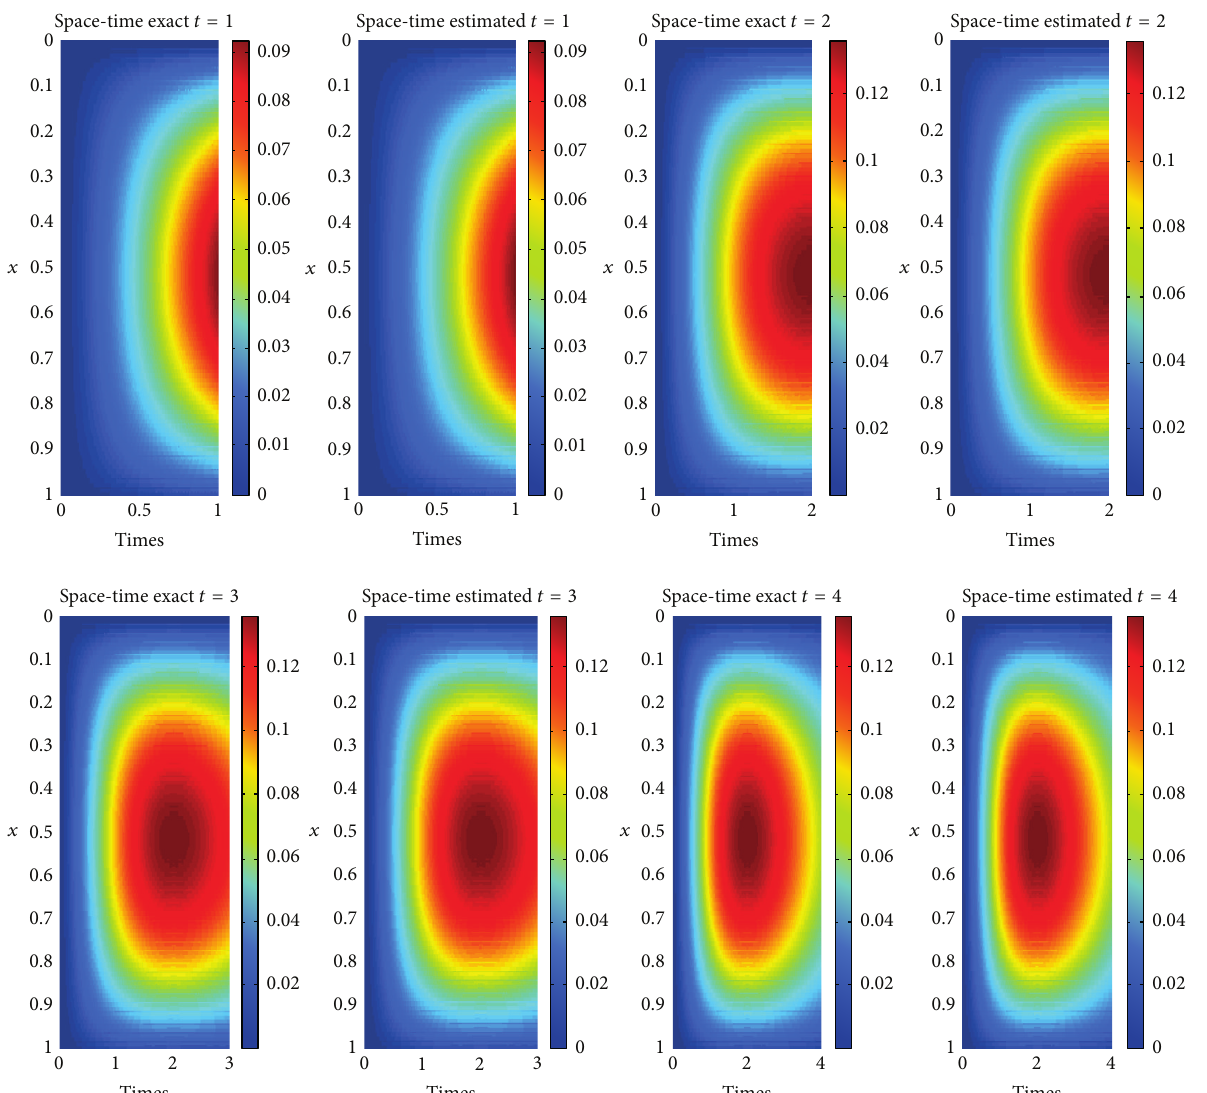
Figure 1: Space-time graph of numerical and analytical solutions at time 𝑡 = 1, 2, 3,4 with 𝑑𝑥 = 0.01 , 𝑑𝑡 = 0.001 and using IMQ (with 𝑐 = 0.09 ) as the radial basis function for Example 1